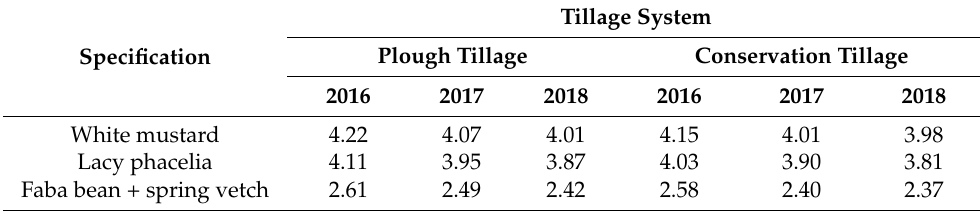
Table 2. Catch crop dry biomass (t · ha − 1 ) after